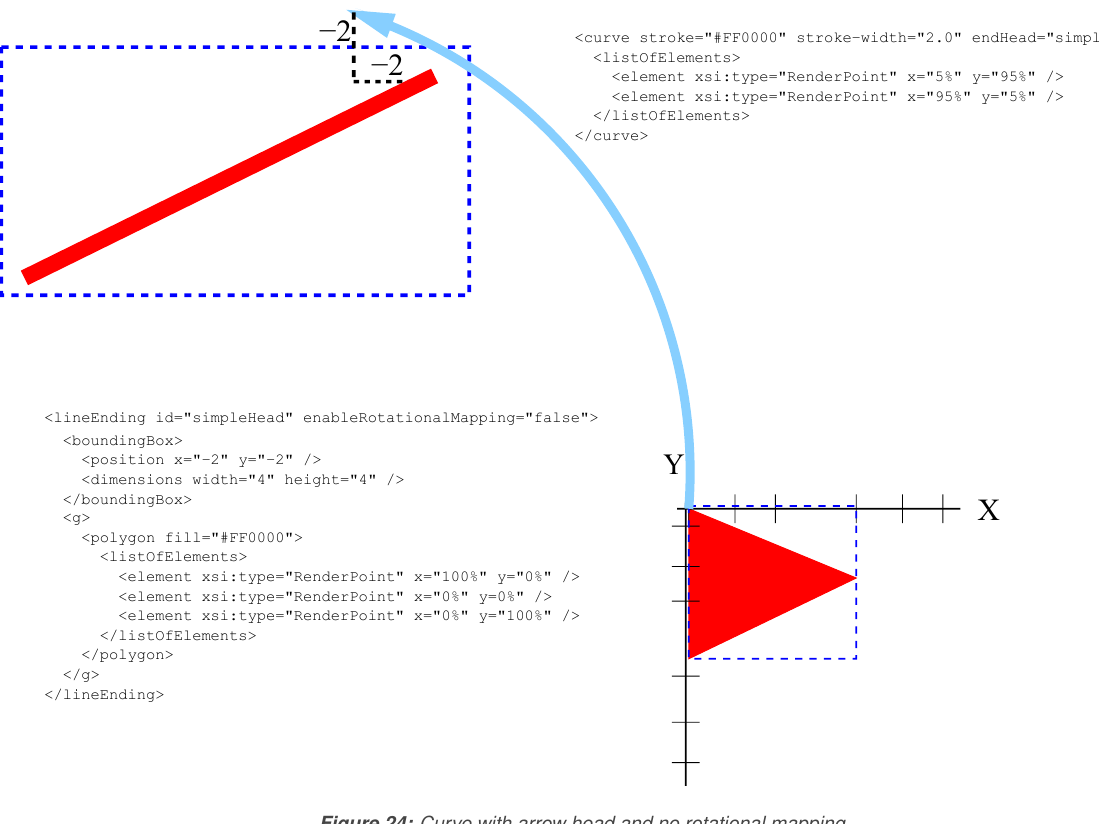
Figure 24: Curve with arrow head and no rotational mapping